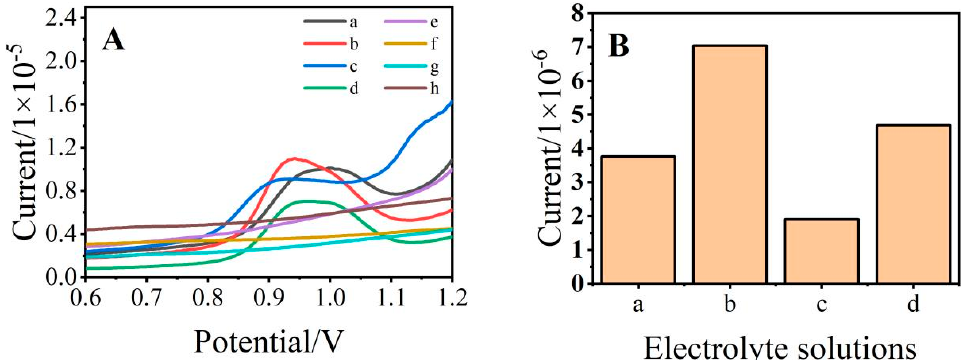
Figure 3. ( A ) Differential pulse diagram of sulfadiazine (SDZ) ( a – d ) and without SDZ ( e – h ) detection in different electrolyte solutions; ( B ) Current response of SDZ detection in different electrolyte solutions; (( a ), NaCl (3.8% pH 4); ( b ), acetic acid-sodium acetate buffer solution (pH 4); ( c ), artificial seawater (pH 4); ( d ), phosphate buffer solution (pH 4); and ( e – h ) refers to ( a – d ) electrolyte solution without